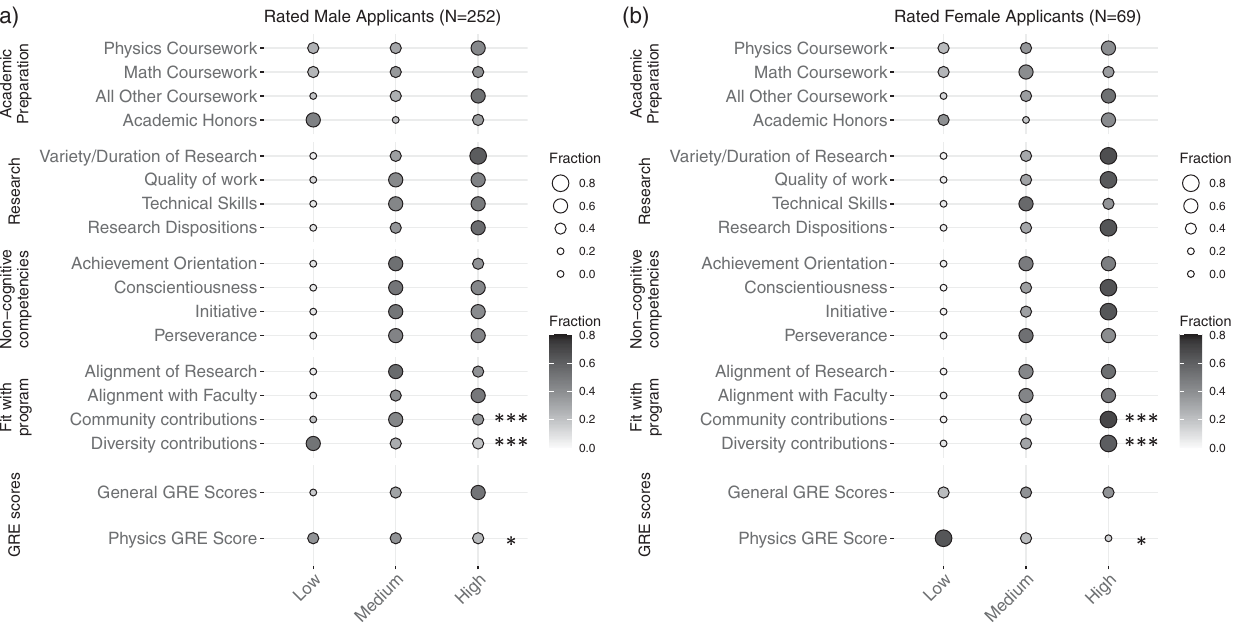
FIG. 3. Faculty ratings of domestic applicants (admitted and nonadmitted) on 18 constructs split by whether the applicant was male or female. Ratings that are statistically different between the two plots are marked on the right side of the plot, with a corrected p value < 0 . 001 represented by ***, < 0 . 01 by **, and < 0 . 05 by *. Only three of the constructs showed statistical differences between males and females: physics GRE score where males scored higher and community contributions and diversity contributions where females scored